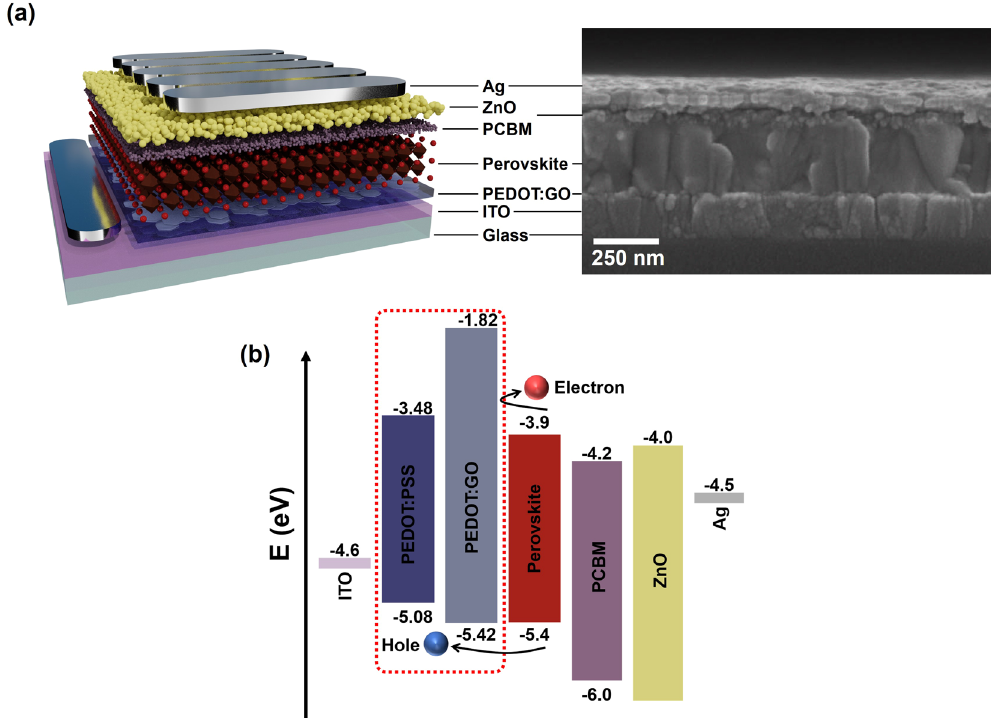
Figure 1. ( a ) The device schematic and SEM cross-sectional image of a perovskite solar cell (ITO/HTL/ perovskite/PCBM/ZnO nanoparticles/Ag) and ( b ) relative energy levels of the various device components in the perovskite solar